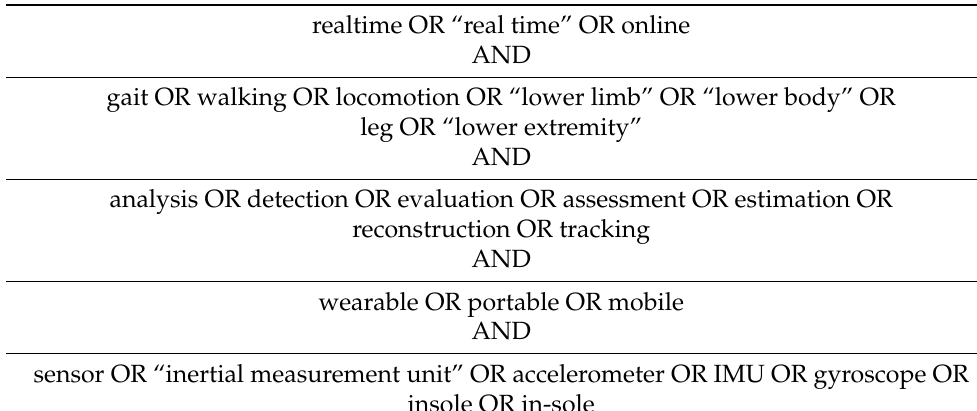
Table 2. Keyword combination used for search in Scopus database which resulted in 697 articles (see Figure 2). The same keyword combination was used in the other databases as well, except adapting syntax to individual search